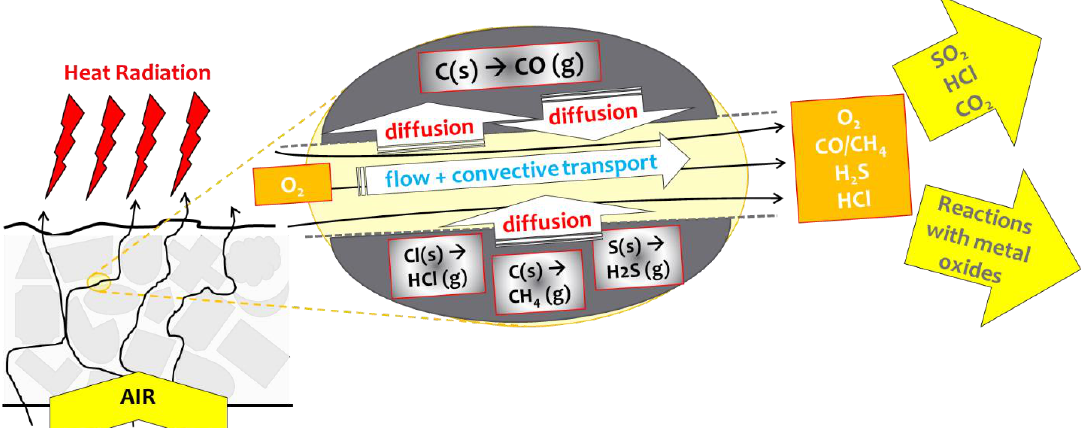
Figure 3. Impact of physical limitations on the thermochemistry of combustion in a (stacked) waste bed on a moving grate. Due to the heterogeneous nature of the reactions taking place (i.e., between